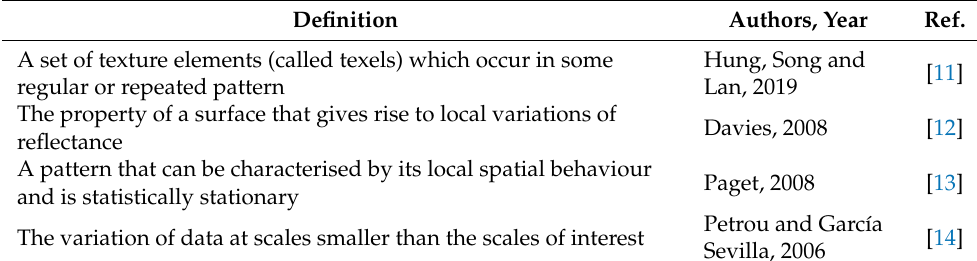
Table 1. Some definitions of texture, sorted by order of appearance (newest